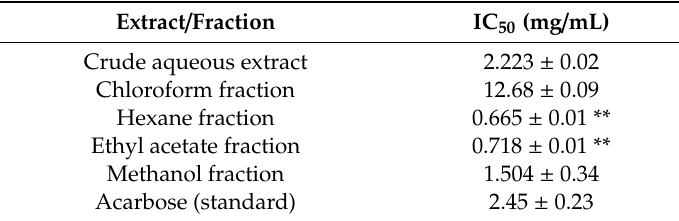
Table 5. IC 50 values exhibited by N. abor-tristis aqueous extract and its fractions against the inhibitory activity of the enzyme α